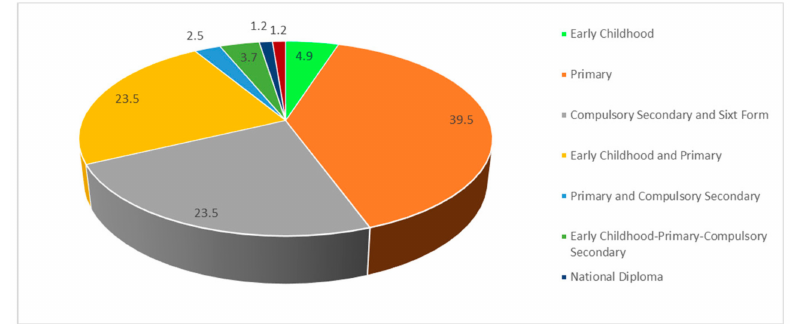
Figure 6. Distribution of teaching proposals according to the target stage of education.